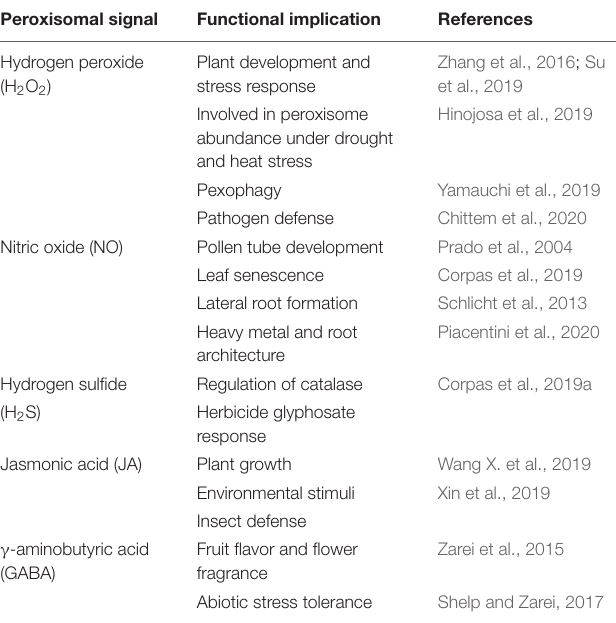
TABLE 2 | Signal molecules generated in plant peroxisomes during different processes and their functional implications. Peroxisomal signal